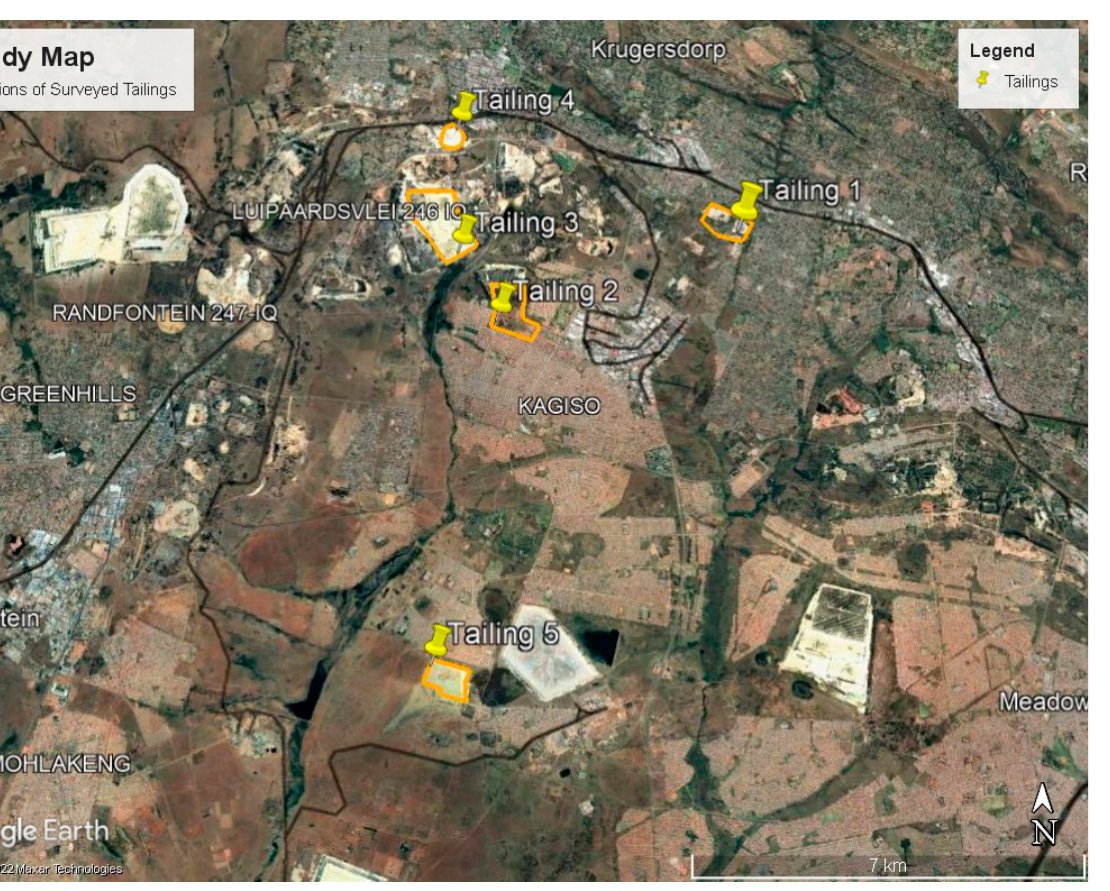
The dose rate measurements were converted from nSv/h to